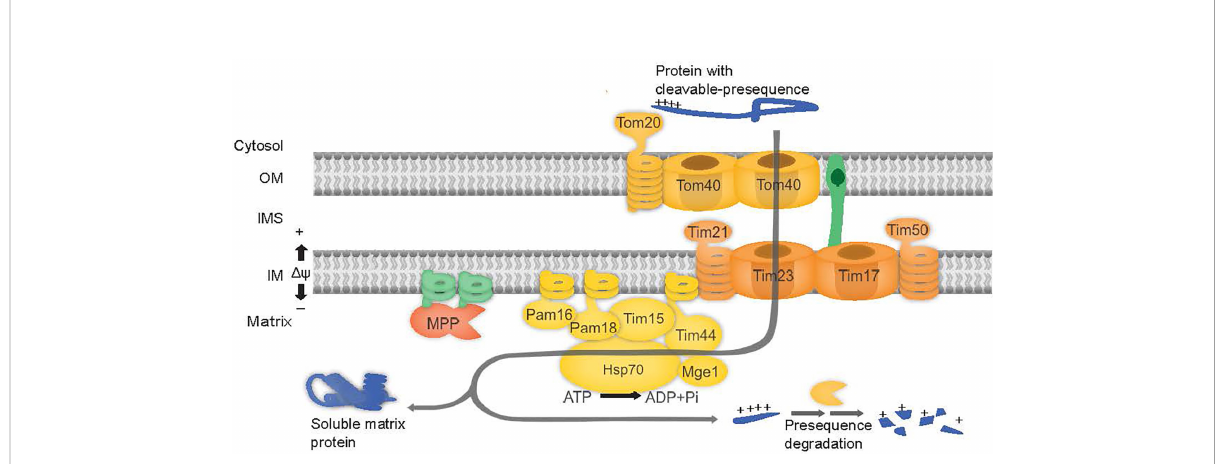
FIGURE 1 PAM complex subunits are involved in mitochondrial protein import. The preprotein binds to the outer membrane (OM) at the TOM complex and is translocated across Tom40. The preprotein is directed to the TIM17:23 complex, consisting of proteins Tim23, Tim17, Tim21, and Tim50. Release of proteins into matrix is powered by ATP hydrolysis via Hsp70 in the PAM complex consisting of proteins Tim44, Tim15, Pam16 and Pam18, Mge1 and